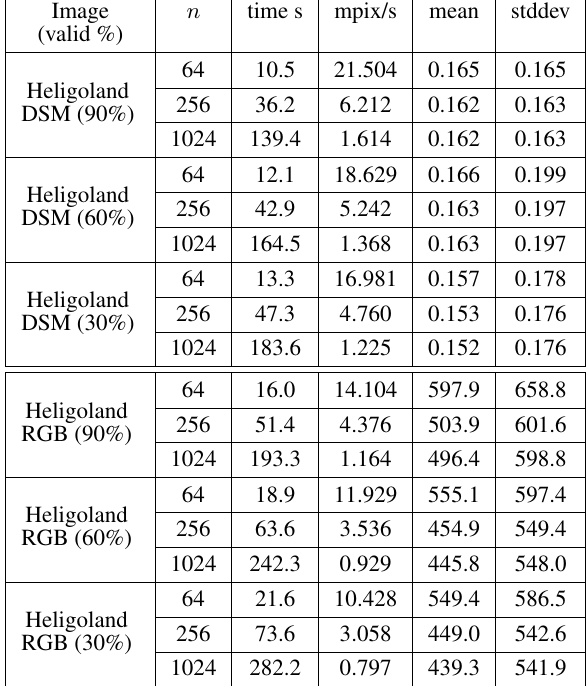
Table 3. Runtime, throughput, mean difference and standard deviation to the reference interpolation for n path orientations for the GPU implementation of the proposed